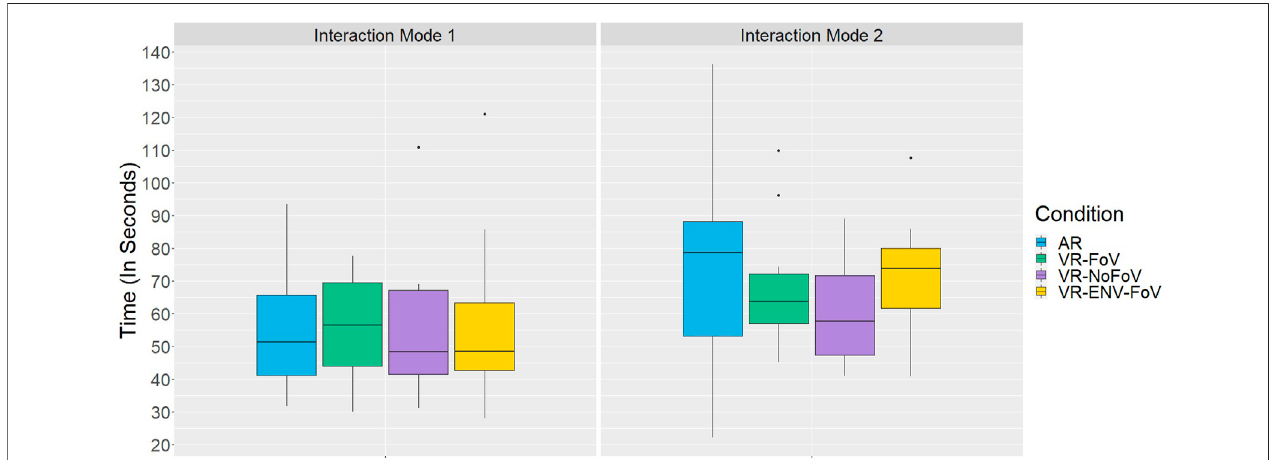
FIGURE 4 | Performances comparison between conditions for both interaction